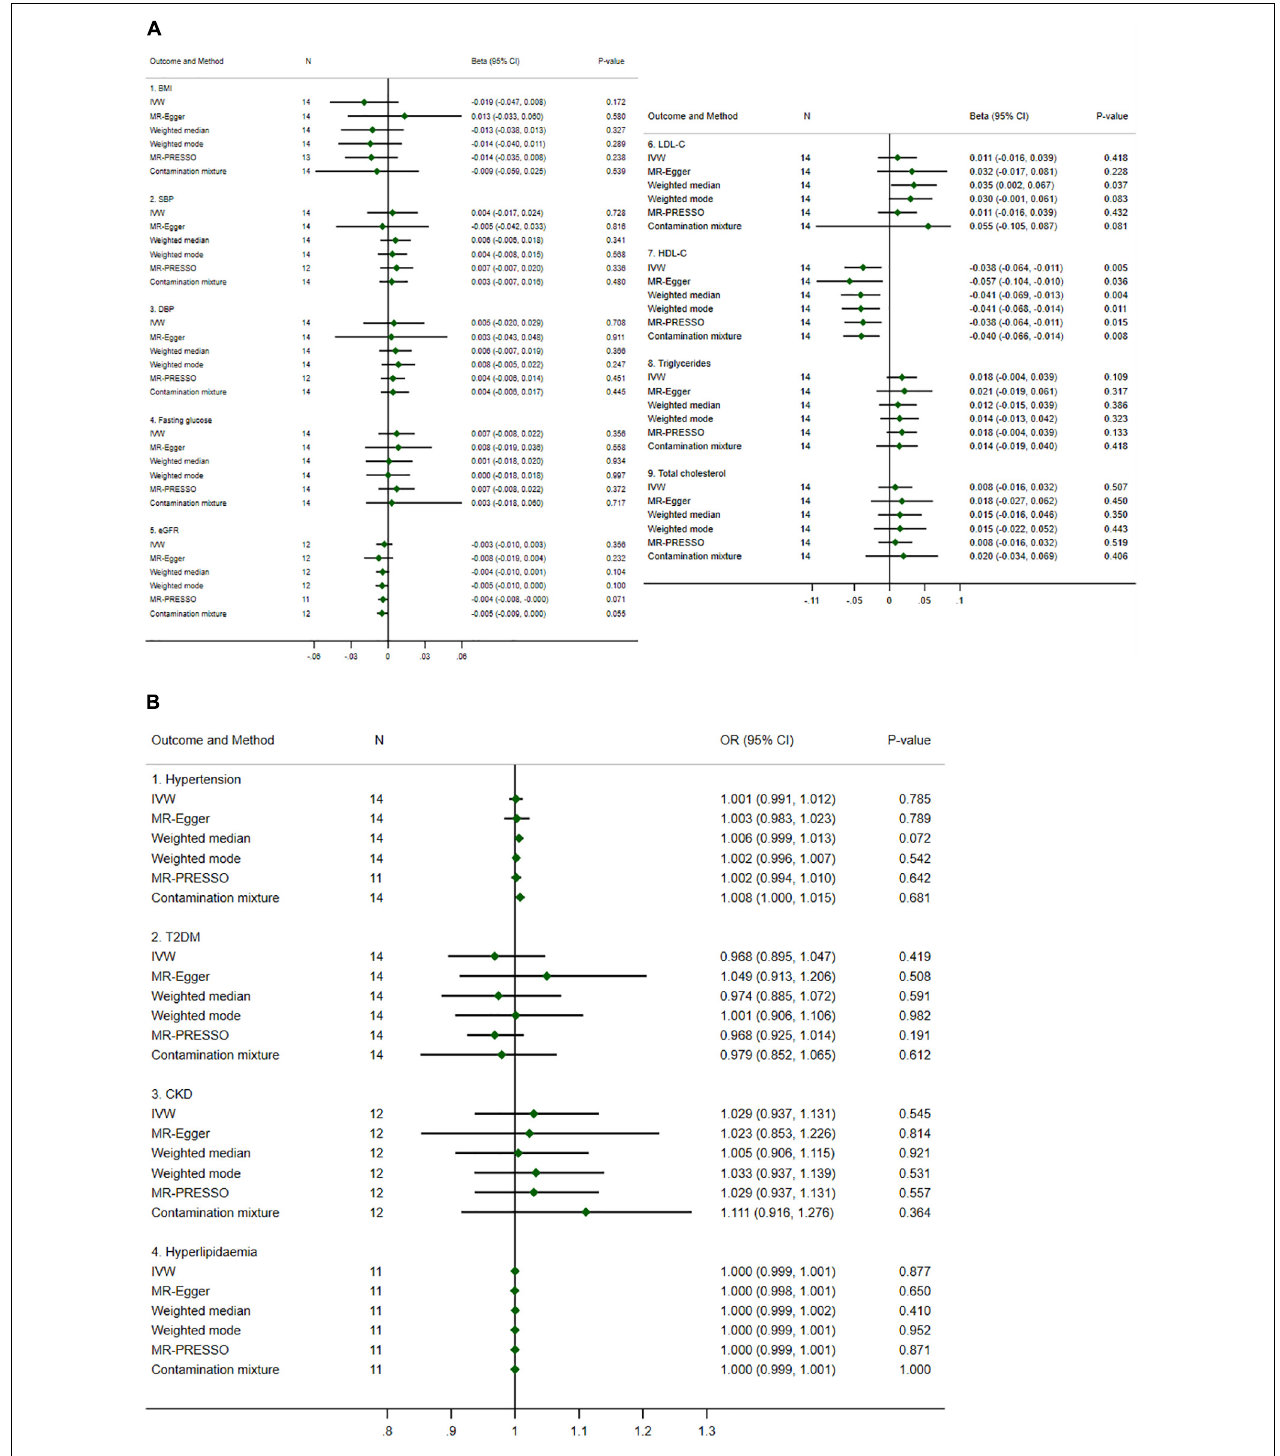
FIGURE 3 | Summary causal effects of genetically predicted urate on cardiovascular risk factors by a biologically driven approach. (A) Continuous outcomes. (B) Binary outcomes. Refer to the unit of continuous outcomes in Table 1 . Confidence interval (CI) from the contamination mixture method for hypertension contained multiple ranges of values (not shown in the figure). IVW, inverse variance weighted; MR-PRESSO, Mendelian Randomization Pleiotropy Residual Sum and Outlier; OR, odds ratio. For abbreviated outcomes, refer to abbreviation lists in Figure 1 .